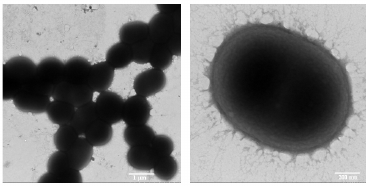
Figure 1. Transmission electron micrograph of Acinetobacter calcoaceticus PA.